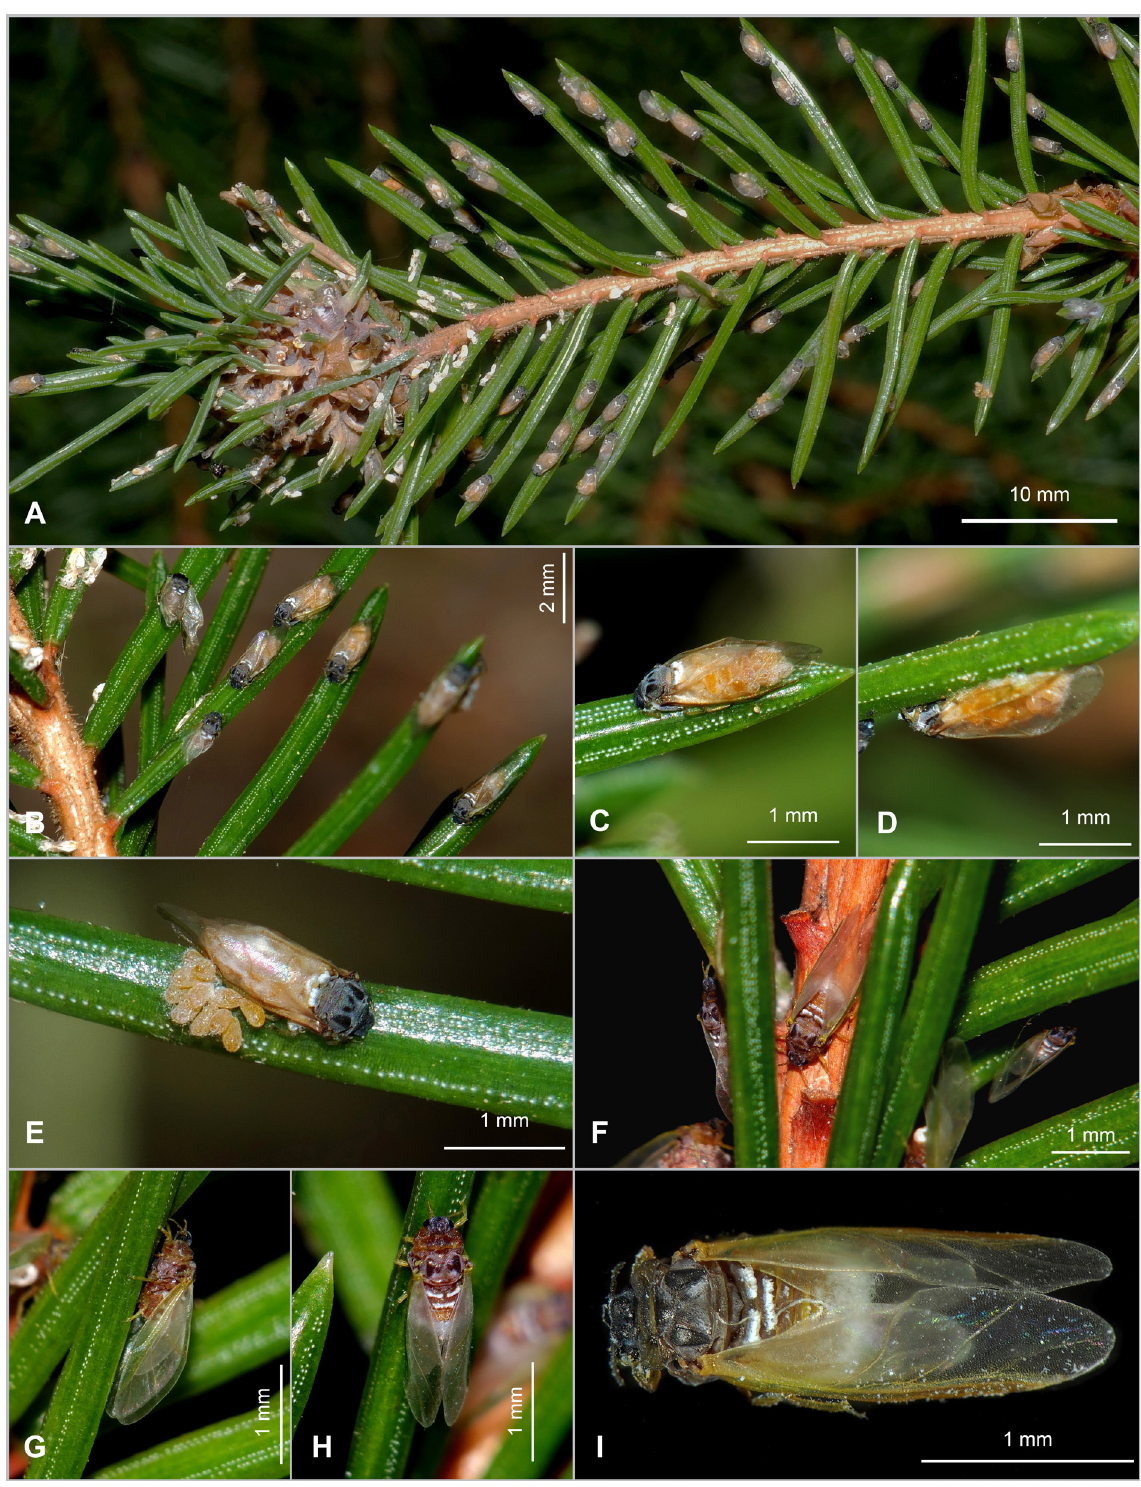
Fig. 19. Adelges (Sacciphantes) abietis (Linnaeus, 1758) on Picea abies . The gallicolae fly only a very short distance from their mother gall ( A–B ), where they lay their eggs ( C–E ). A majority of the eggs remain on the mother’s dorsum, sheltered by her wings. Newly hatched alatae are red-brown ( F–G ), head and thorax darkening with age ( I